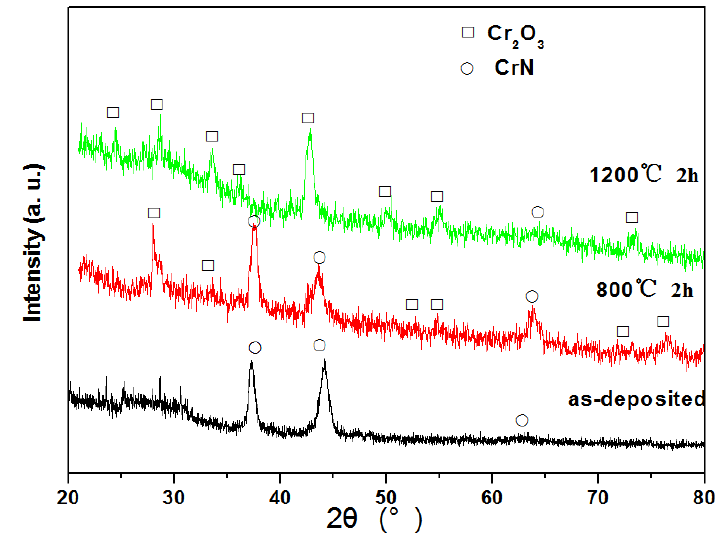
Figure 9. XRD spectra of Cr–Si–N coatings before and after oxidation.